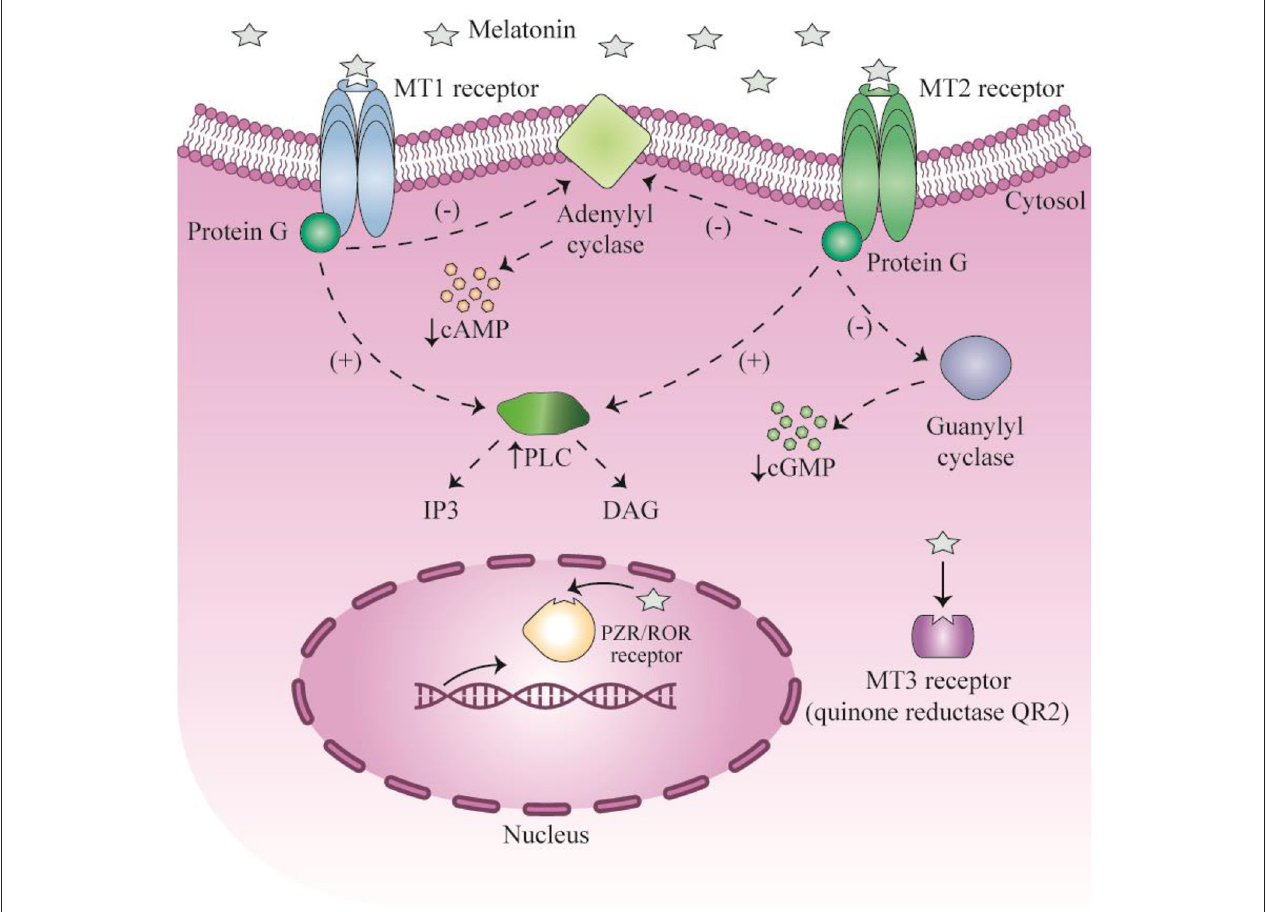
FIGURE 1 | Signaling of melatonin and their receptors. This figure adapted from Millet-Boureima et al.